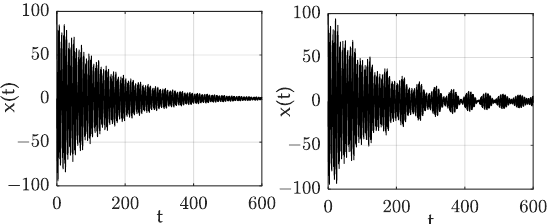
Figure 3. Response of point A, with F=0 ( left ) and F=1 ( right ).